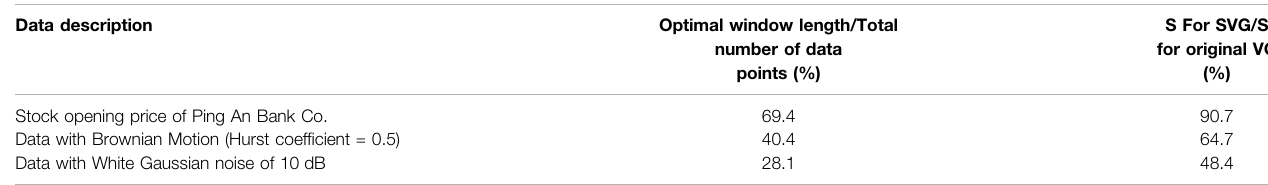
Stock opening price of Ping An Bank